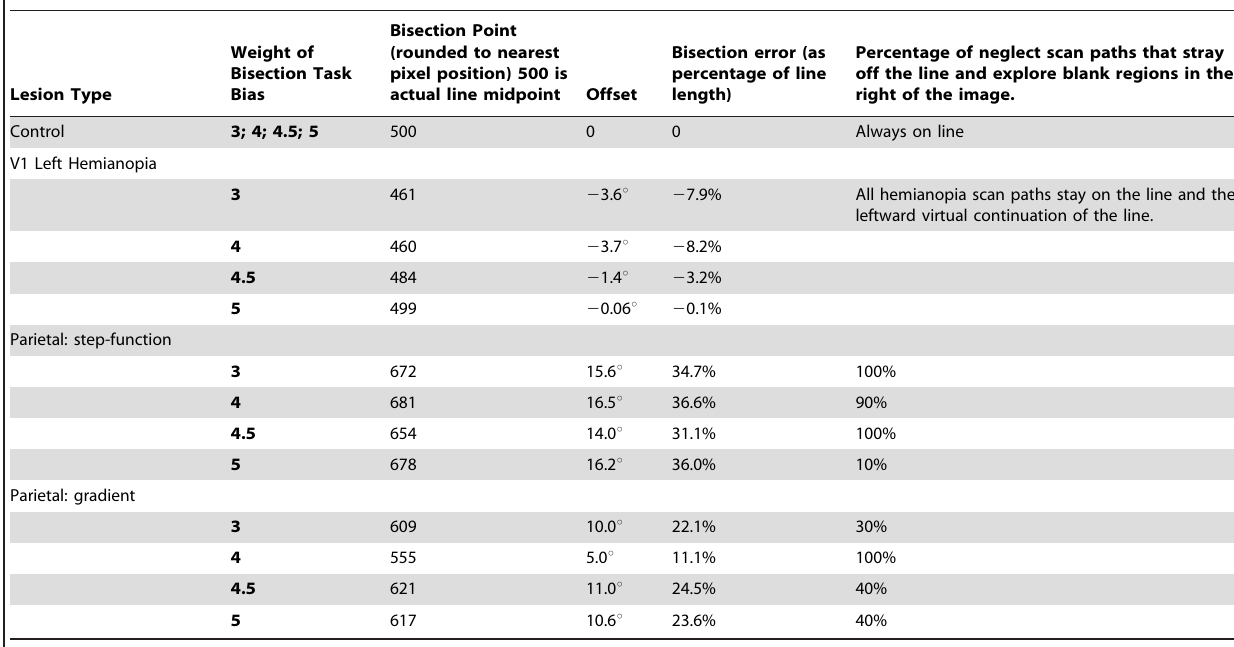
Table 1. Comparison of bisection errors under different lesion conditions whilst varying the weight of the bisection bias.